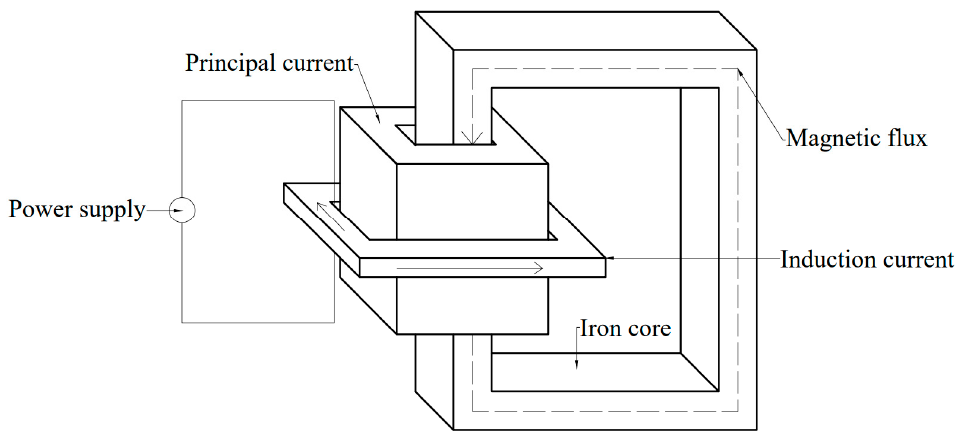
Figure 1. Schematics of the channel-type induction heating principle of the tundish [23] .